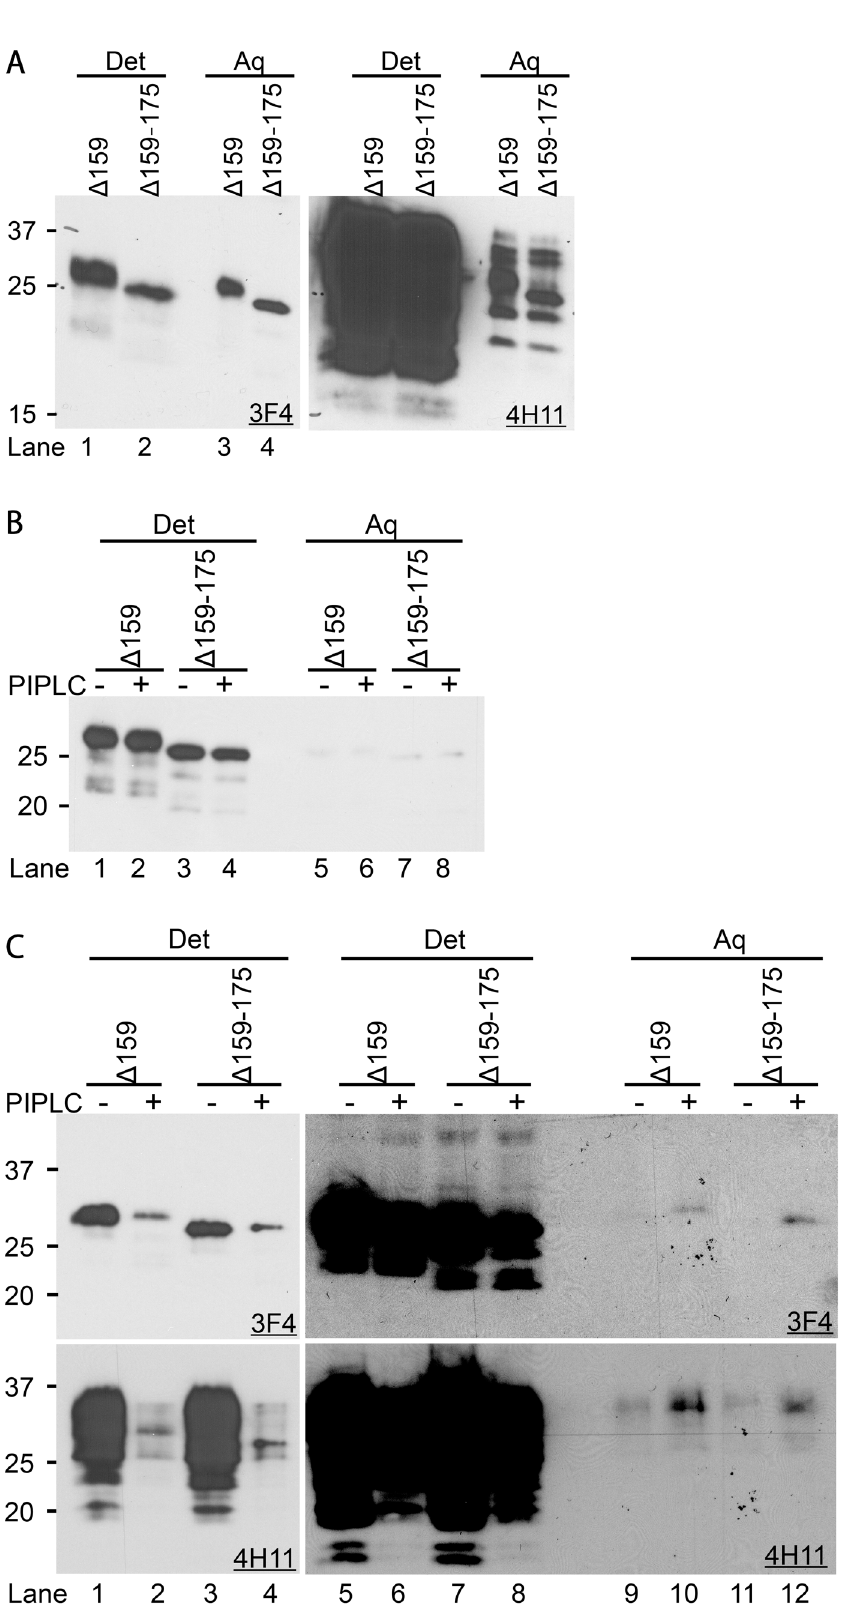
Figure 4. D PrPs have a GPI-anchor attached. A. D PrPs are substantially soluble in detergent without GdnHCl denaturation. Immunoblots probed with mAbs 3F4 (left) or 4H11 (right, membrane re-probed) showing D PrPs and endogenous PrP in detergent and aqueous phases of TX114 lysates prepared from N2a cells transfected with D 159 or D 159–175. Det denotes detergent phase, Aq aqueous phase. B. D PrPs are highly hydrophobic after denaturation with GdnHCl. Representative immunoblot of TX114-treated lysates after denaturation with 3 M GdnHCl and